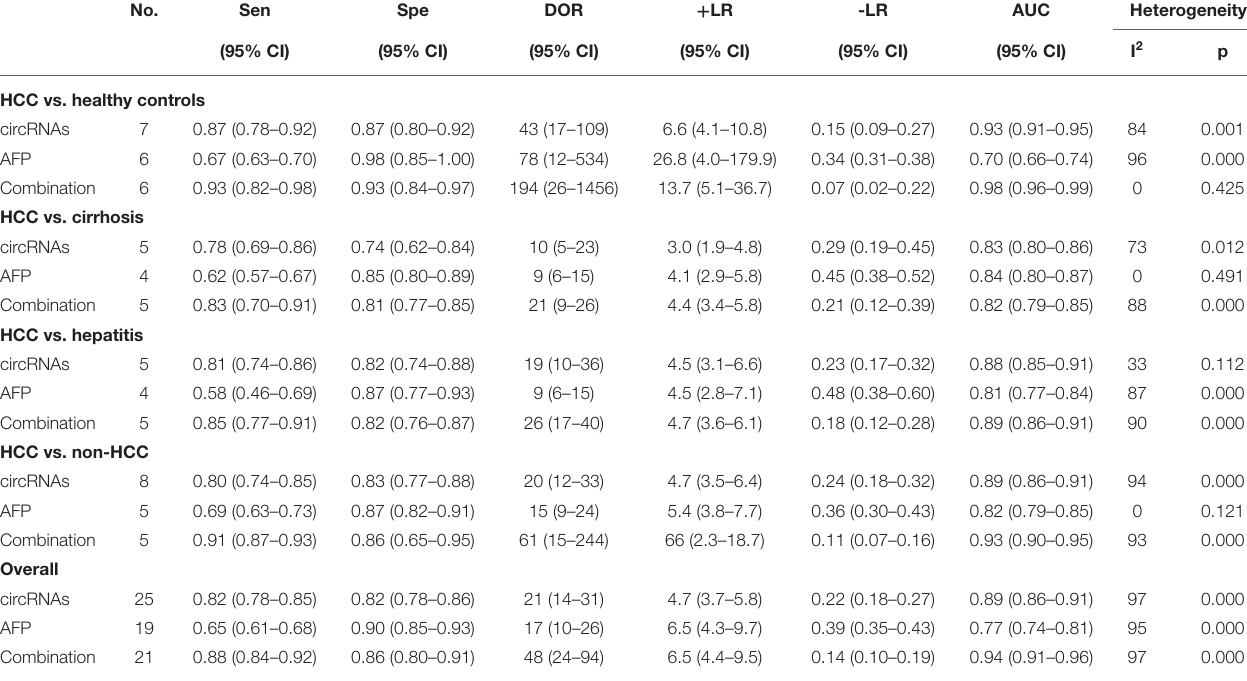
TABLE 1 | Subgroup analysis of diagnostic